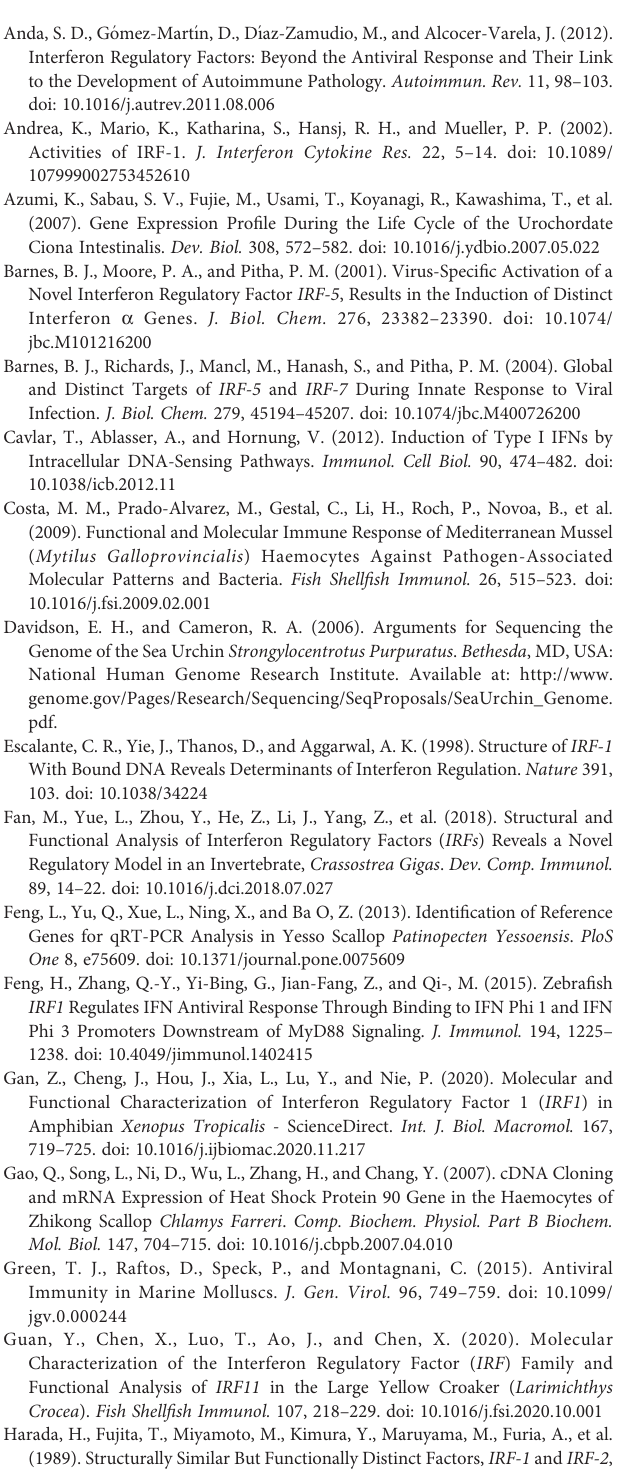
Supplementary Figure 2 | The expression pro fi les in different developmental stages and adult tissues. (A) . Expression levels of CfIRFs in different embryonic and larval stages. (B) . Expression levels of CfIRFs in adult tissues. Vertical bars